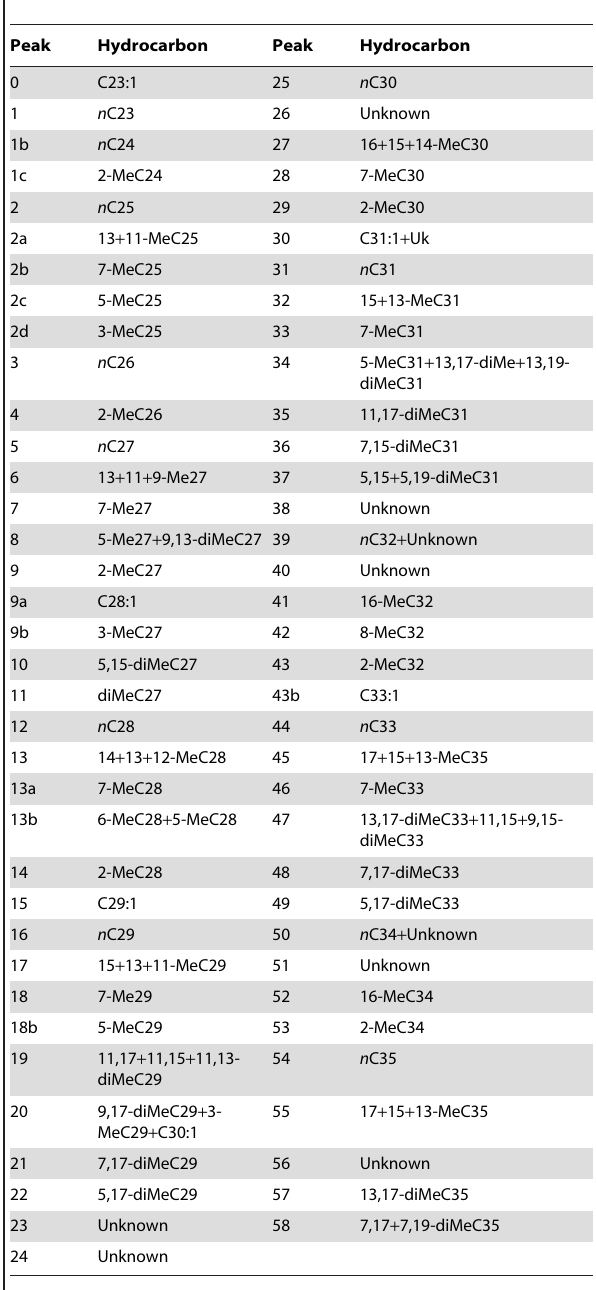
Table 1. Cuticular hydrocarbons of Polistes dominulus and P. nimphus